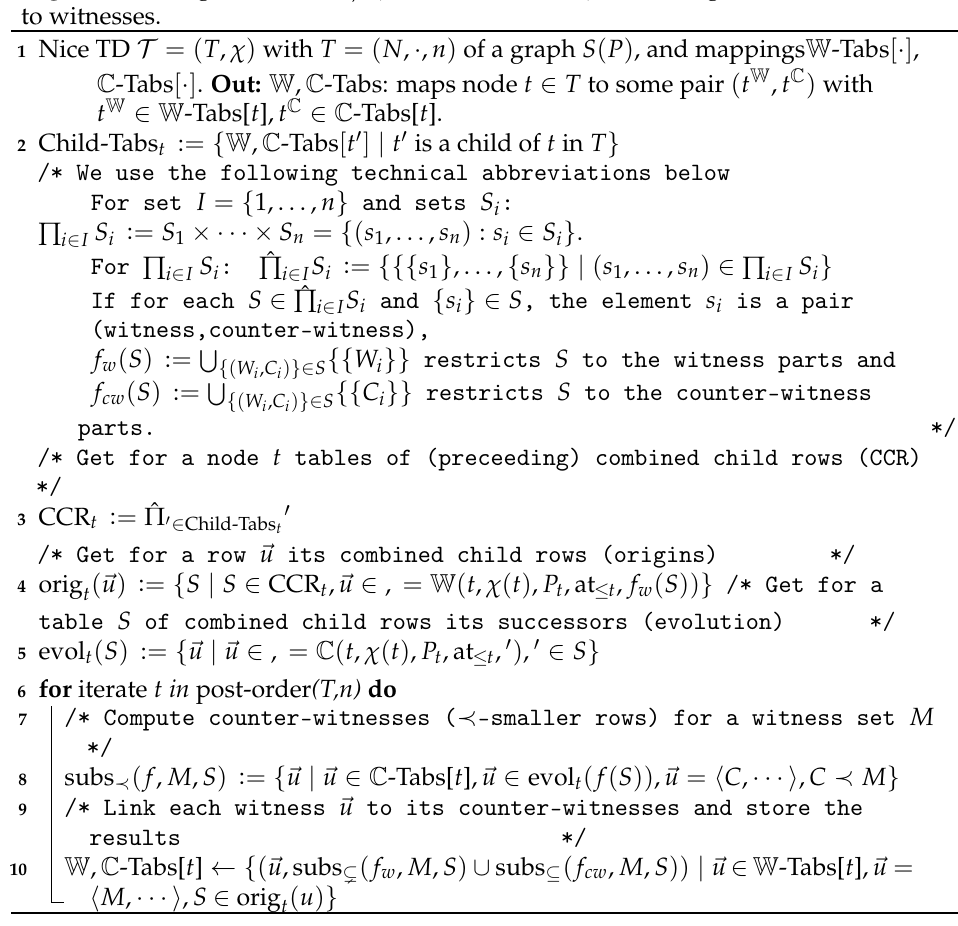
Algorithm 3: Algorithm DPL W , C ( T , W -Tabs, C -Tabs ) for linking